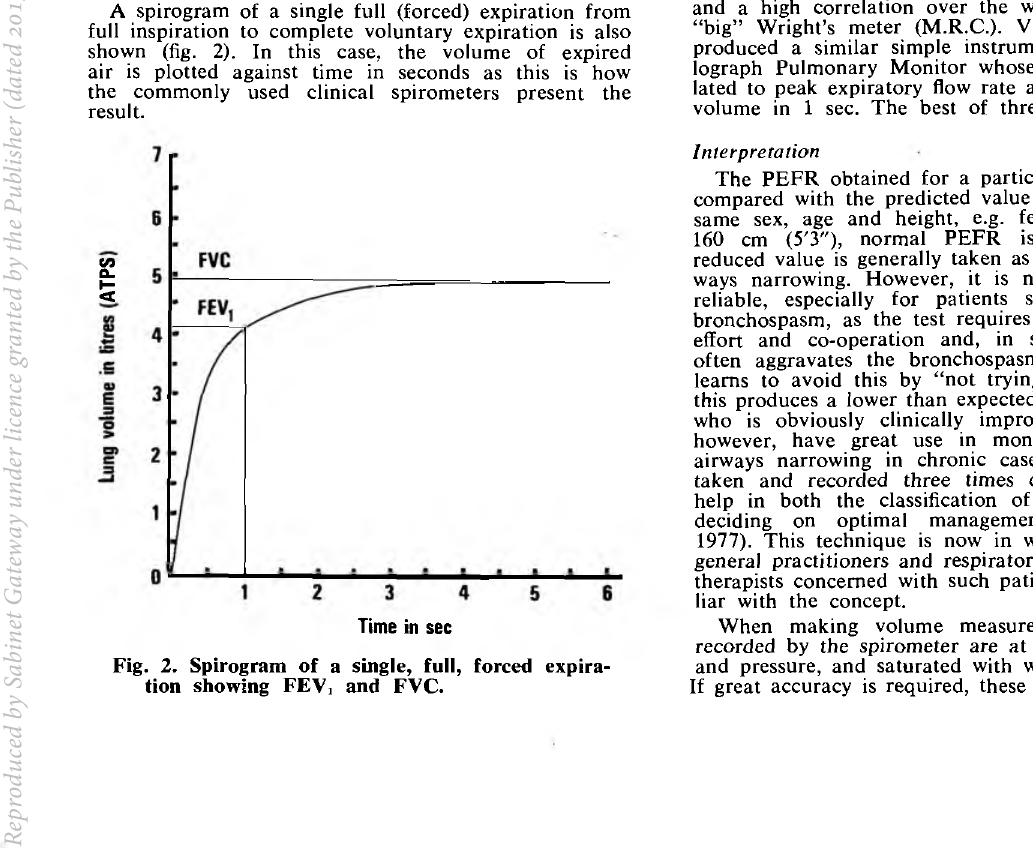
Fig. 1. A spirogram of a subject breathing nor­ mally, then taking a full deep breath, breathing